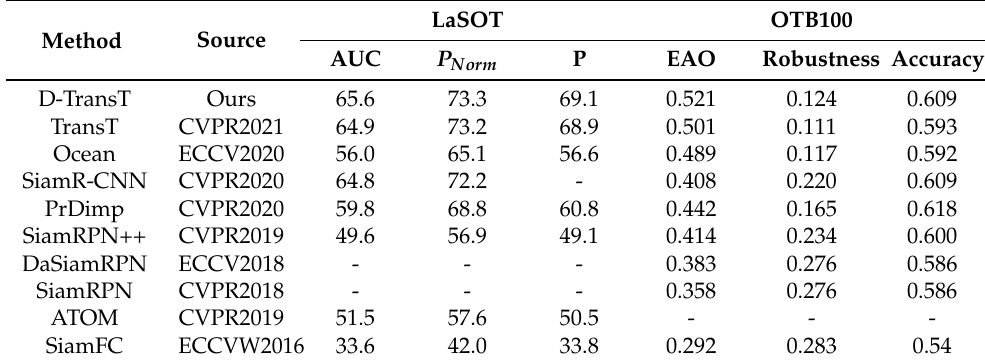
Table 2. State-of-the-art comparison on LaSOT and OTB100.